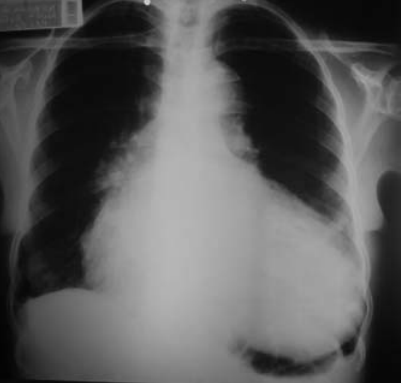
Figure 3 - Transthoracic echocardiography showing severe mitral regur- gitation